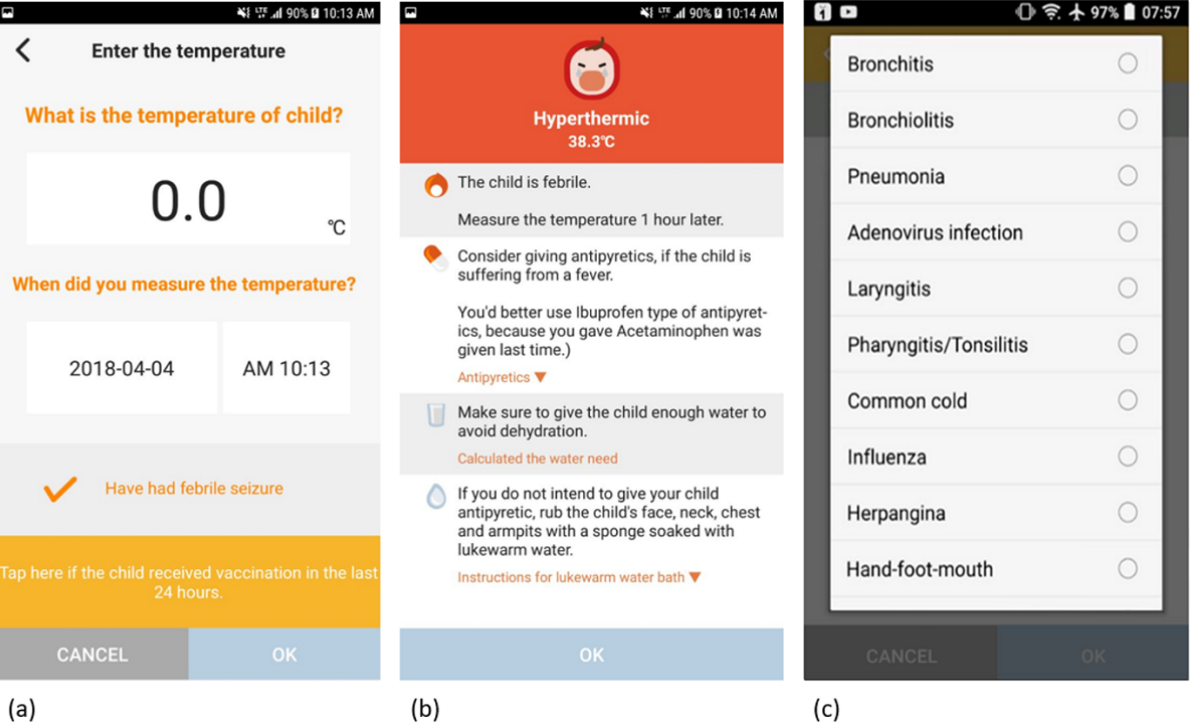
Figure 1. Screenshots of Fever Coach app. (a) body temperature page, (b) fever management page, (c) diagnosis page. The service is not provided in English and is translated from Korean for these screenshots. (options list: bronchitis, bronchiolitis, pneumonia, adenovirus infection, laryngitis, pharyngitis/tonsillitis, common cold, influenza, canker sore, herpangina, hand-foot-mouth, enterocolitis, meningitis, otitis media, urinary tract infection, mumps, scarlet fever, chicken pox, measles, roseola, not diagnosed, and